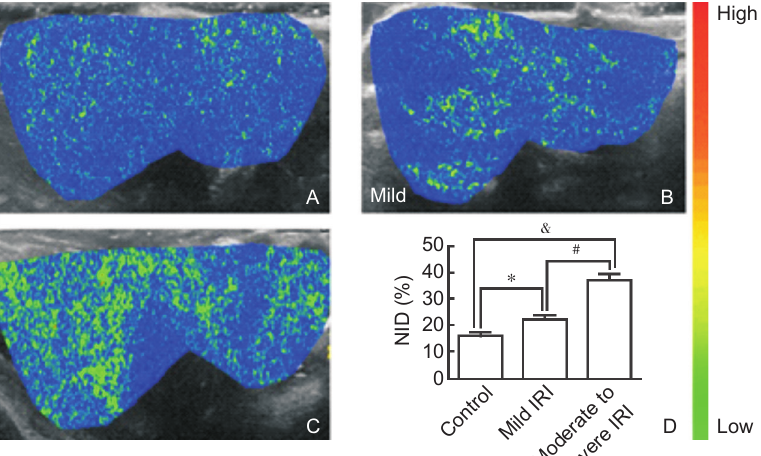
Figure 13 Representative targeted ultrasound (US) images evaluating different degrees of ischemia–reperfusion injury (IRI). Targeted US imaging signal was weakest in the control liver (A) and strongest in the moderate to severe IRI liver (C) compared with that in the mild IRI liver (B); (D) The normalized intensity difference (NID) in each group. ( * P < 0.001 mild IRI group vs control group, # P = 0.002) moderate to severe IRI group vs mild IRI group, & P < 0.001 moderate to severe IRI group vs control group). (Reprinted with permission from reference